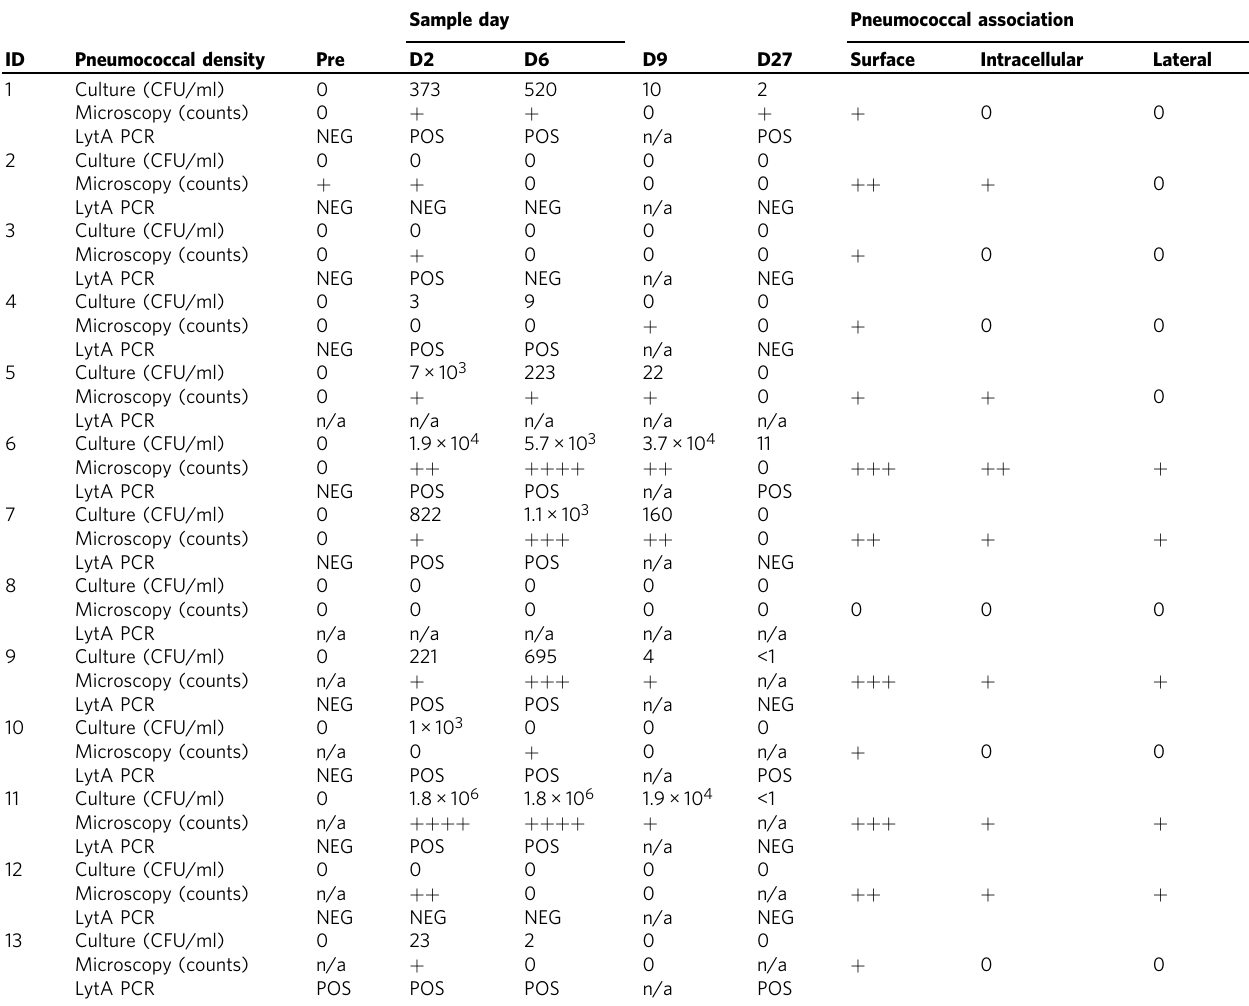
Table 1 S. pneumoniae association with the nasal epithelium in the EHPC model detected by culture, confocal microscopy and LytA